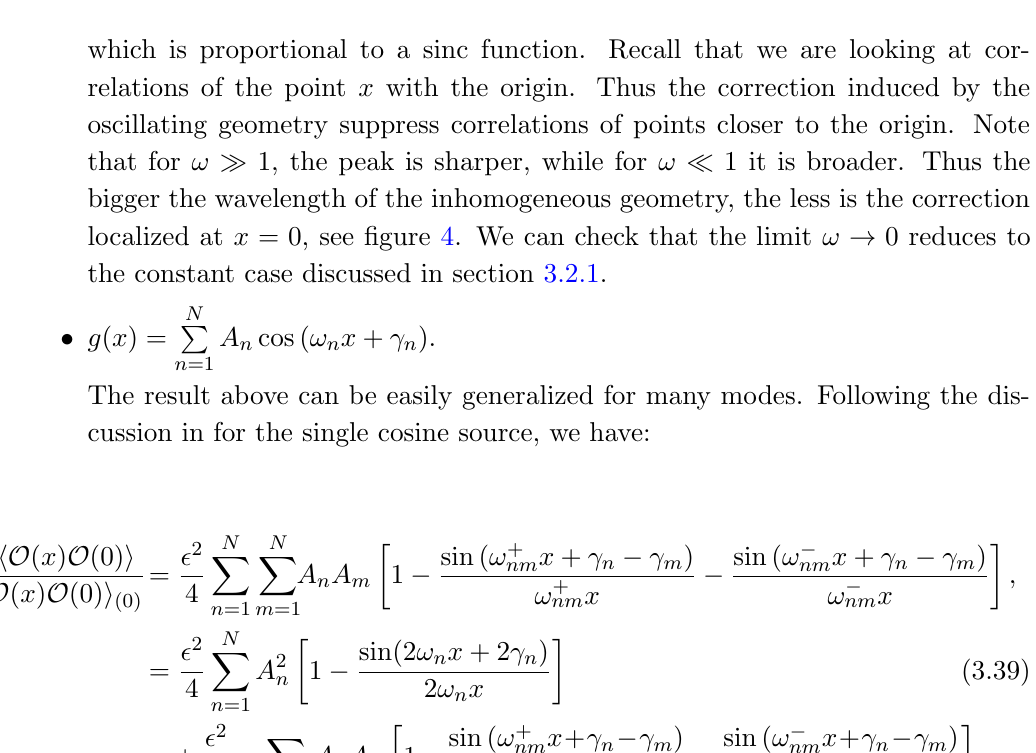
Figure 4 . Two-point function hO ( x ) O (0) i = hO ( x ) O (0) i geometry g tx = (cid:15) cos !x , from eq. (3.38). On the left, we (cid:12)x the frequency and plot di(cid:11)erent amplitudes of (cid:15) , on the right we (cid:12)x (cid:15) and plot di(cid:11)erent frequencies, in a log-log